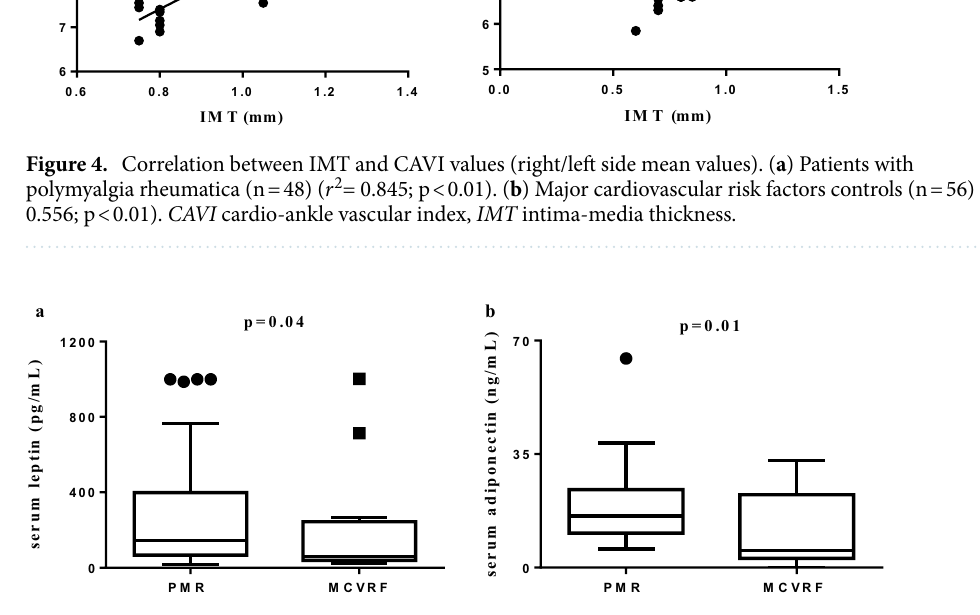
Figure 5. Comparison of adipokines serum levels in patients with PMR (n = 40) and MCVRF controls (n = 18). ( a ) Serum leptin levels. ( b ) Serum adiponectin levels. Data are shown as Tukey boxplots; lines represent the median level with 25th–75th percentile; data not included between the whiskers are plotted as outliers with dots. PMR polymyalgia rheumatica, MCVRF major cardiovascular risk